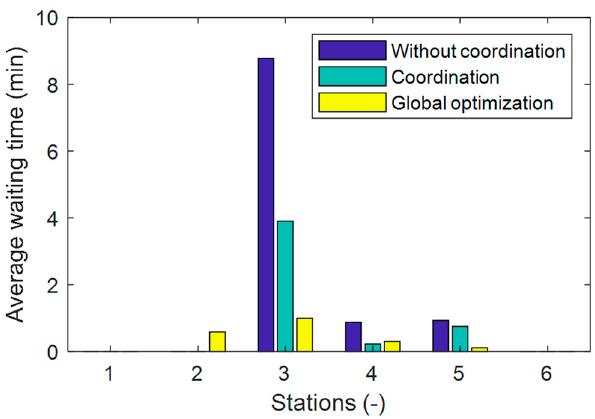
Figure 10. Average waiting time comparison.